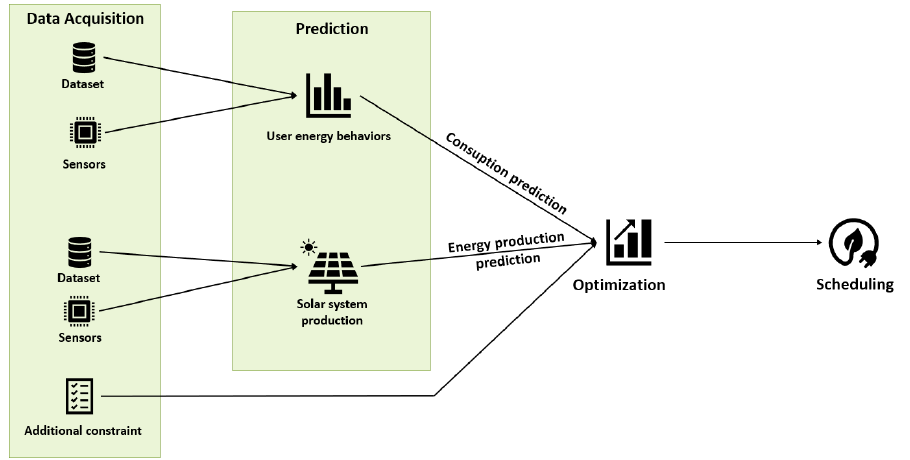
Figure 1. The system architecture.